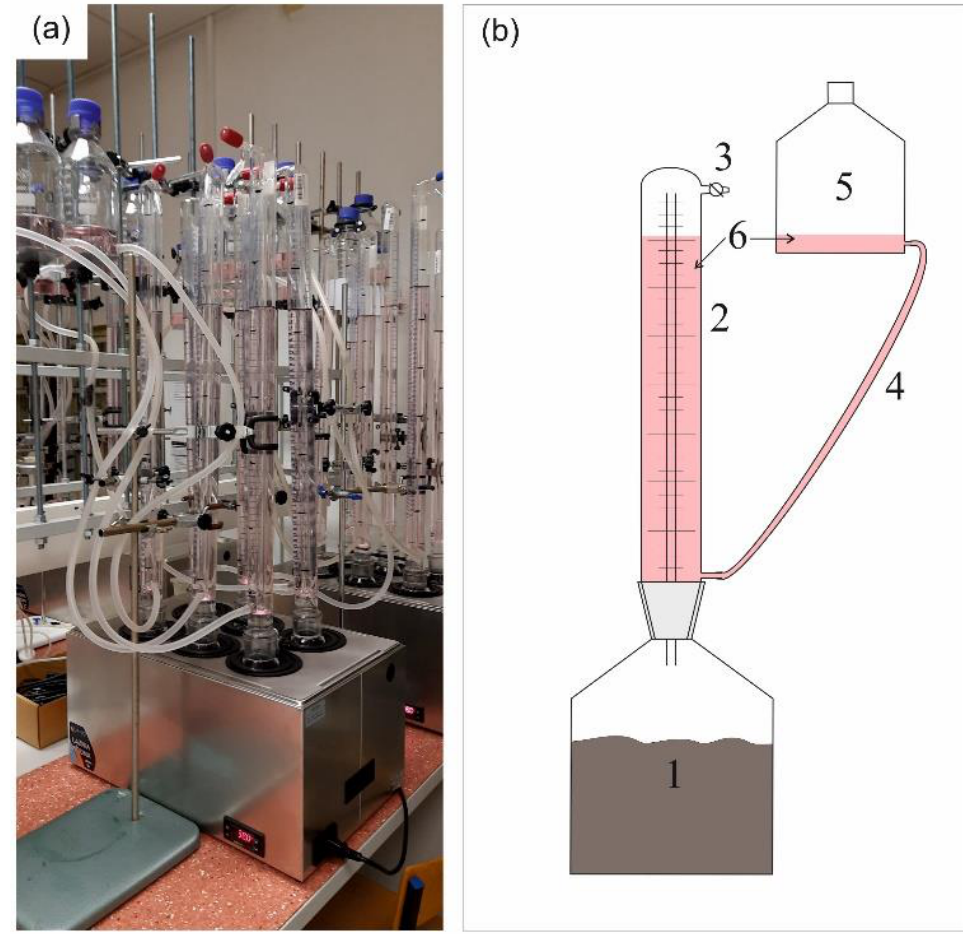
Figure 1. The BMP experiment ( a ) eudiometer sets in water bath; ( b ) the eudiometer set: 1 — glass bottle (reactor) with mixture of inoculum and substrate, 2 — the eudiometer with internal glass tube for gas transport, 3 — valve for gas sampling, 4 — connecting tube, 5 — pressure compensation reservoir, 6 — confining liquid.